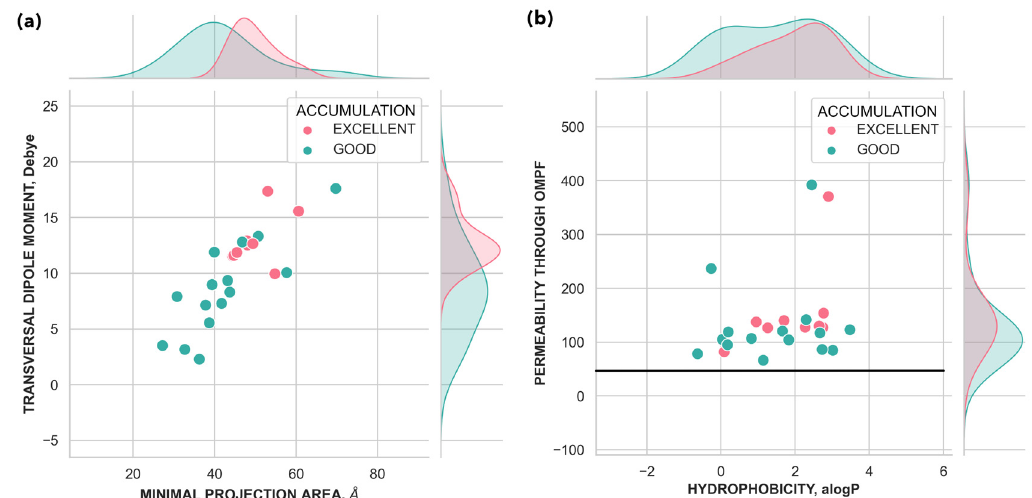
Figure 5. Molecular descriptors distributions for good/excellent accumulators: ( a ) compound minimal projection area and the transversal component of the total dipole moment and ( b ) permeability through OmpF versus hydrophobicity. Data points are colored according to good (green) or excellent accumulation values (magenta).